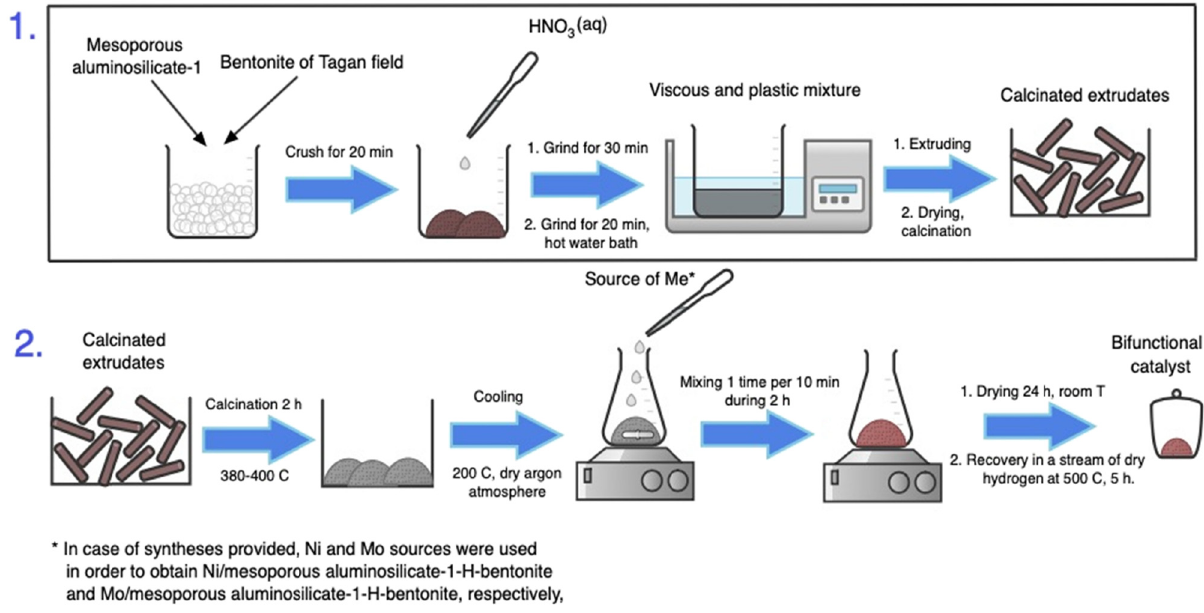
Figure 2: Scheme of synthesis of bifunctional catalysts Ni/MAS - H - bentonite and Mo/MAS - H - bentonite based on MAS: 1. Preparation of calcinated extrudates; 2. Promotion of the